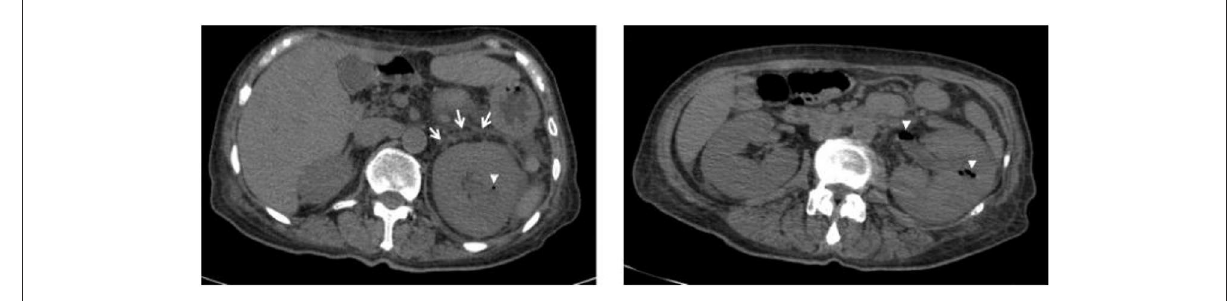
FIGURE1 CT scan revealed gas collection in the parenchyma and renal pelvis (arrowheads) and perirenal fascia thickening (arrows) of the left kidney.